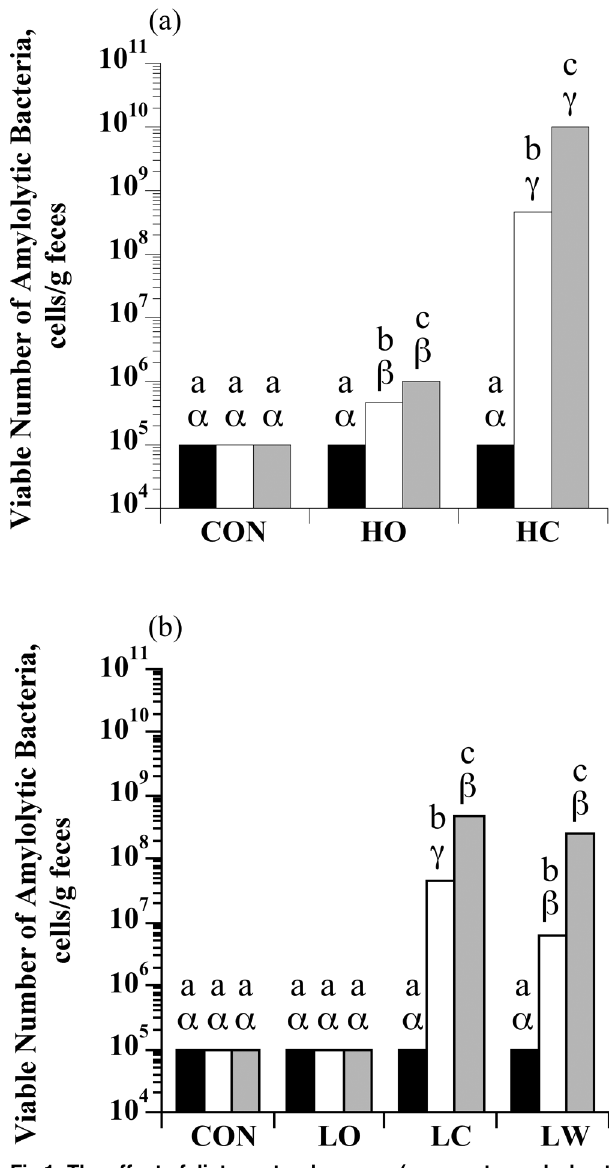
Fig 1. The effect of dietary starch source (corn, oats, and wheat middlings) on the viable number of total amylolytic bacteria in equine feces. (a) Horses were assigned to treatments: hay only (CON; n = 4), high oats (HO; n = 4; 2 g starch/kg BW), or high corn (HC; n = 4; 2 g starch/kg BW). (b) Horses were assigned to treatments: hay only (CON; n = 5), low oats (LO; n = 5; 1 g starch/kg BW), low corn (LC; n = 5; 1 g starch/kg BW), or low wheat middlings (LW; n = 5; 1 g starch/kg BW). An initial sample was obtained at the end of the forage-only feeding period (S0; black bars) before starch sources were introduced. Additional samples were taken on d 6 when horses were receiving 50% of the assigned starch source (S1; open bars) and on d 13 when they were receiving 100% of the assigned starch source (S2; grey bars). The enumerations were performed in anaerobic liquid media with soluble starch as the growth substrate. The tubes were incubated (37°C, 3 d), and the final dilution exhibiting bacterial growth was recorded as the viable number. Means lacking a common English letter are different within sample day ( P < 0.05). Means lacking a common Greek letter are different between sample days within a treatment ( P < 0.05); (a) Treatment: P < 0.0001, sample day: P < 0.0001, and treatment × sample day: P < 0.0001; Pooled SEM: treatment = 0.0731, sample day = 0.0780, and treatment × sample day = 0.1351 (log 10 transformed); (b) Treatment: P < 0.0001, sample day: P < 0.0001, and treatment × sample day: P < 0.0001; Pooled SEM: treatment = 0.1109, sample day = 0.0794, and treatment × sample day = 0.1588 (log 10